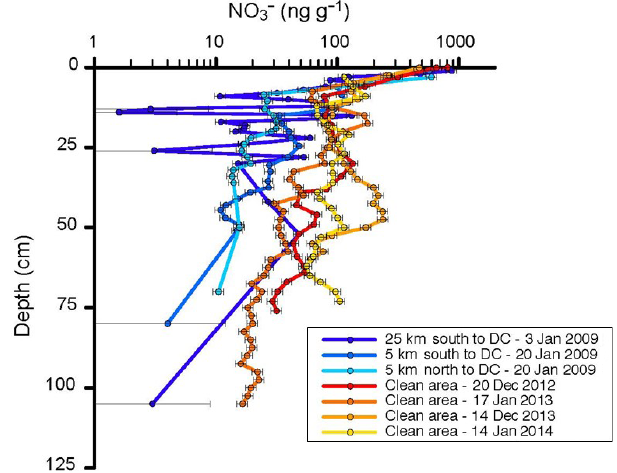
Figure 9. Nitrate concentration in snow pits in proximity ( ≈ 20m) to the snow towers at the border of the clean air sector (warm col- ors), and sampling locations up- and downwind of Concordia (cold colors). Sampling dates are indicated in the figure legend. Horizon- tal error bars depict the estimated uncertainty of the chemical anal- ysis, i.e., 10% at > 10ngg − 1 , 50% between 5 and 10ngg − 1 , and 100% at < 5ngg − 1